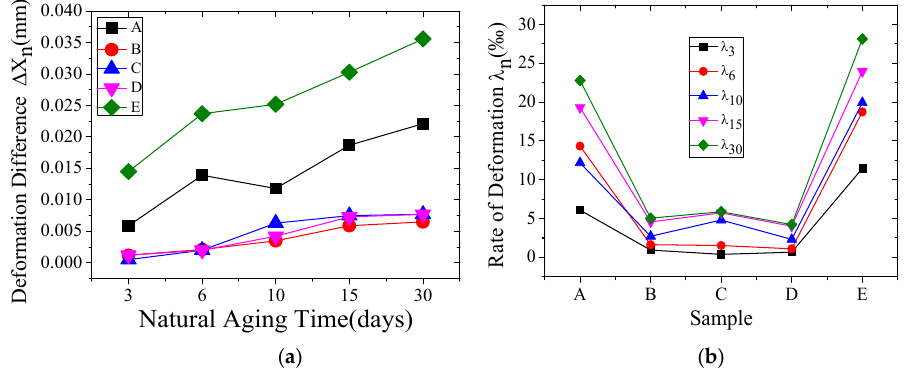
Figure 14. Deformation comparison after vibration stress relief and after machining. ( a ) Deformation difference; ( b ) change in the rate of deformation.